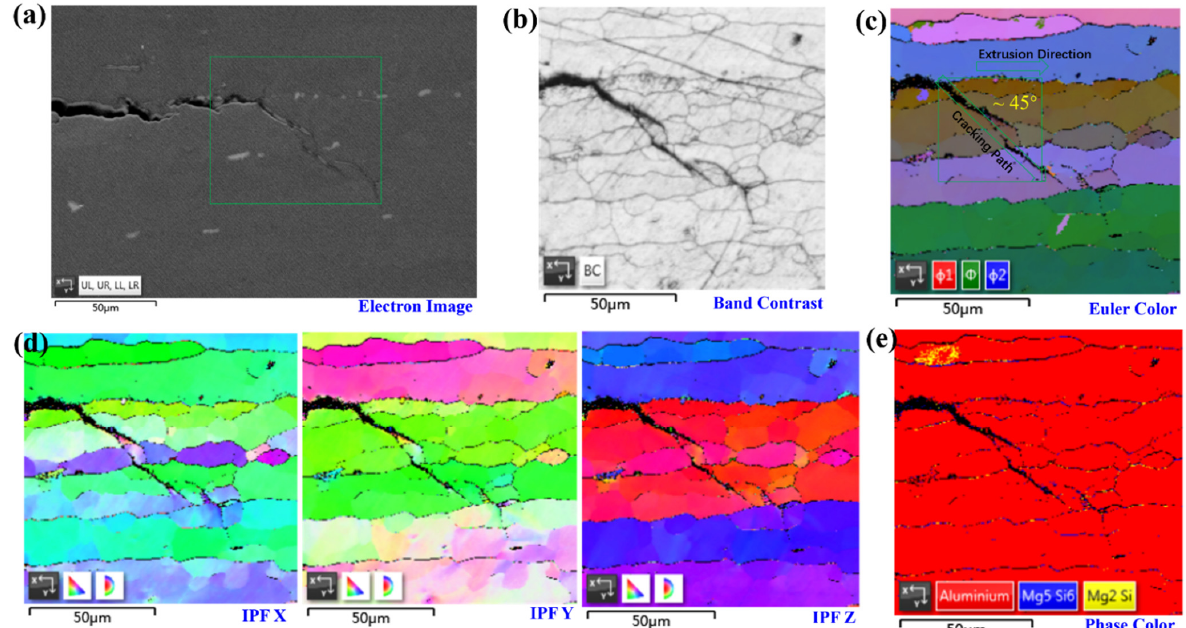
Figure 5. The classical cracking features at the SCC tips characterized by EBSD: ( a ) the electron image of the crack tips together with precipitates and IGC; ( b – e ) the characterizations of selected regions in terms of band contrast, Euler color, the inverse pole figure (IPF) of the x-, y-, and z-axes, and the phase map, respectively.